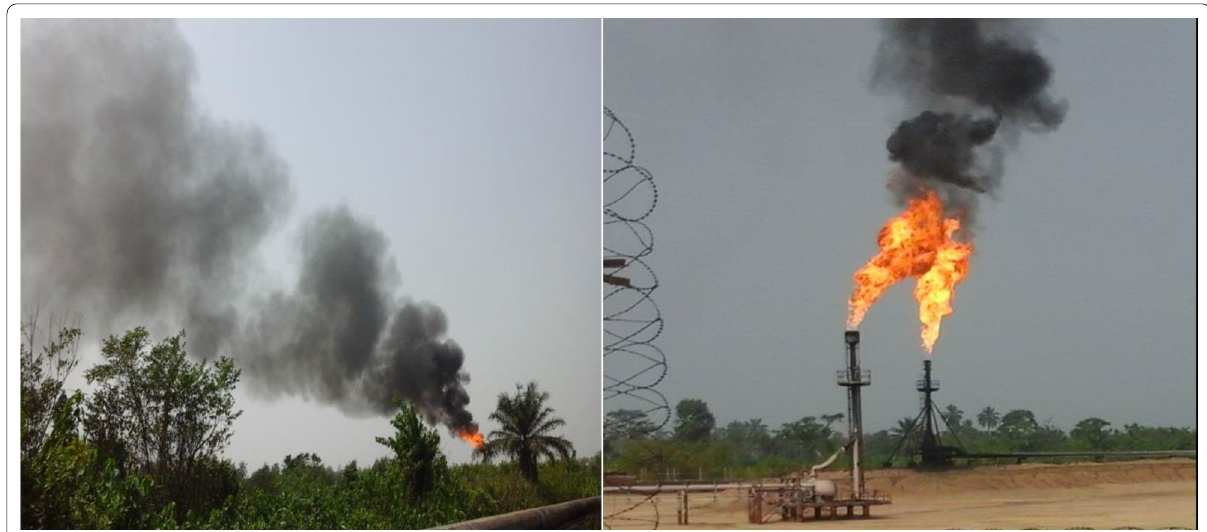
Fig. 2 A typical gas faring stack in the study